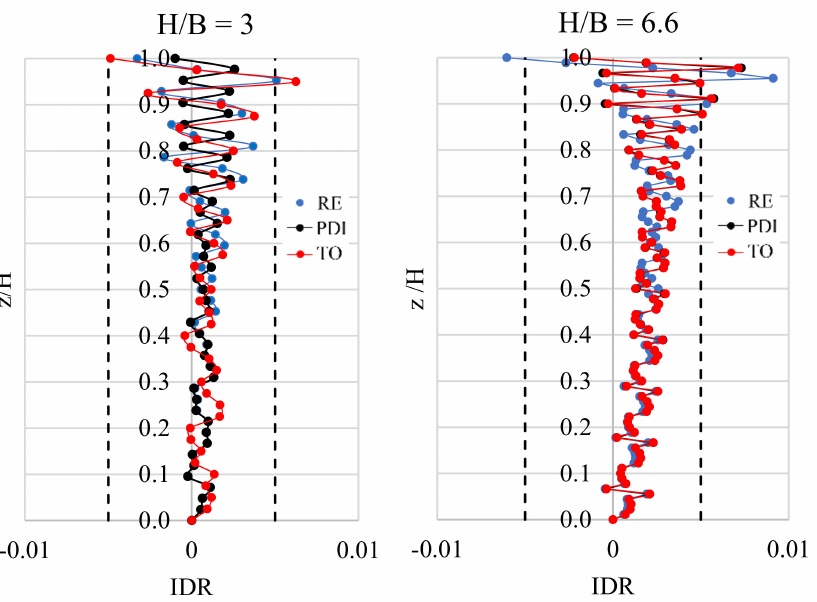
Figure 18. Performance assessment of the analysed patterns: